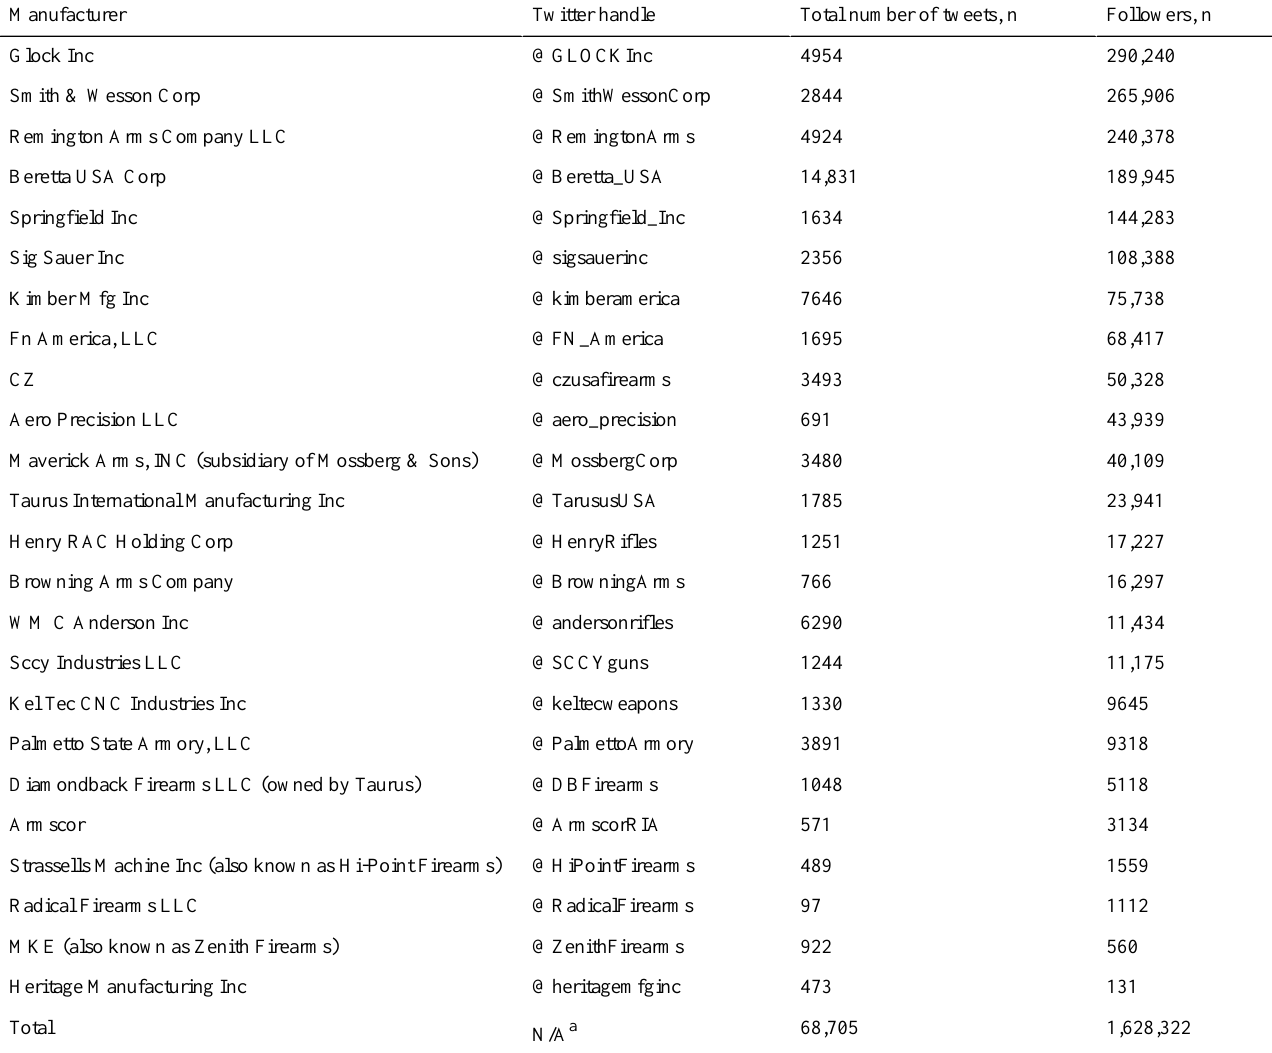
Table 2. Twitter archive summary for top domestic firearm manufacturers by